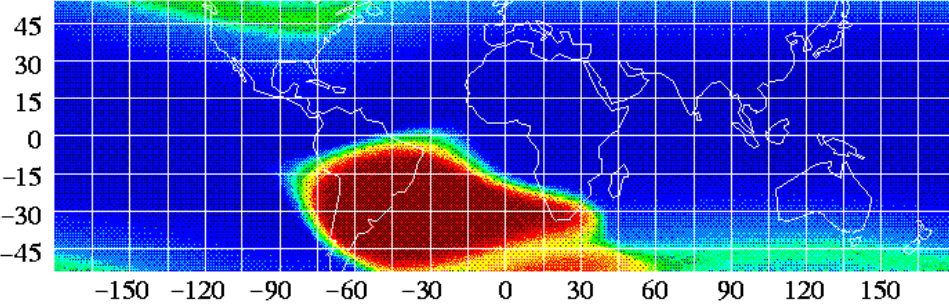
Figure 5. South Atlantic Anomaly (SAA, red area) [34]. Credit: NASA .